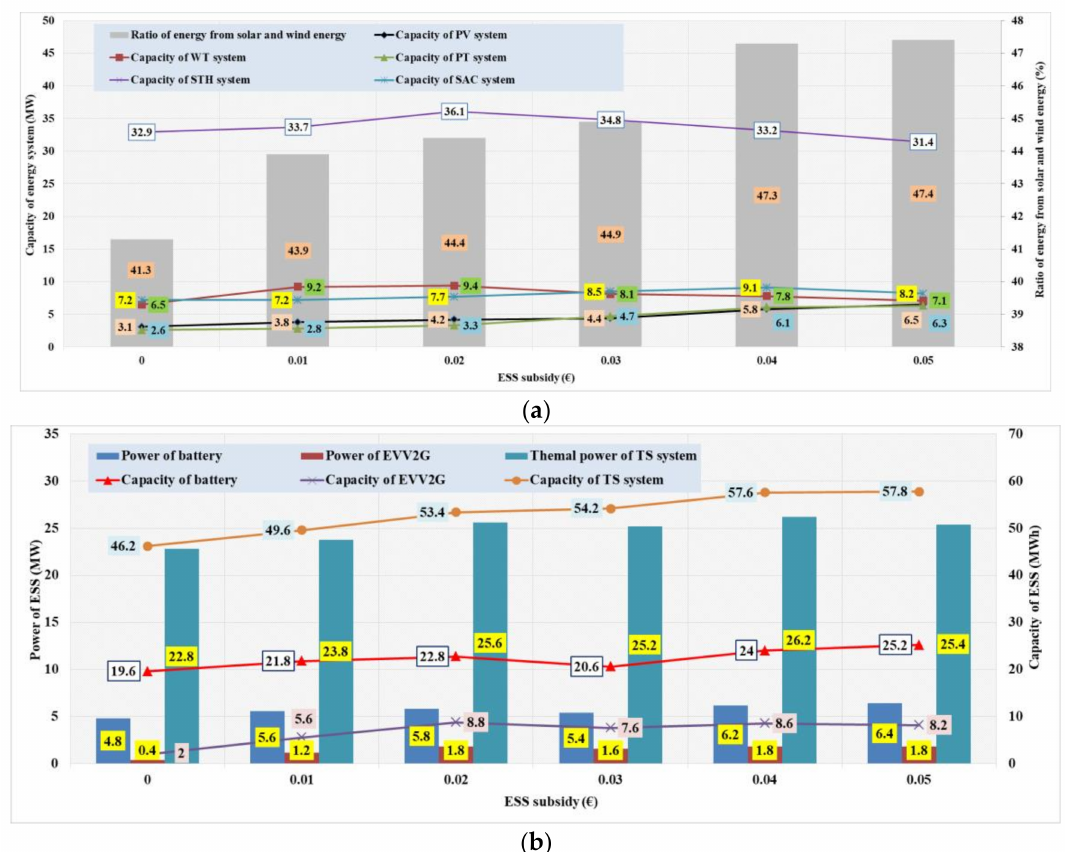
Figure 5. Parametric study for ESS subsidy. Variations on solar/wind energy system and ESSs with increasing subsidy for ESS. ( a ) Size variation of solar and wind energy system; ( b ) Size variation of